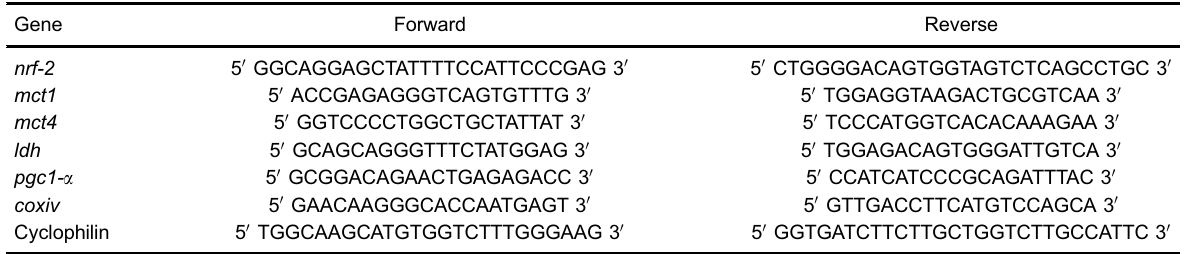
Table 1. qRT-PCR primer sequences.